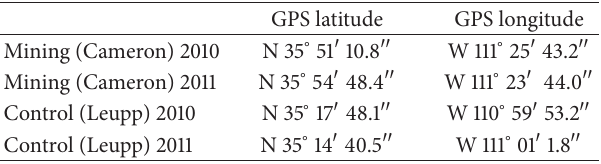
Table 1: GPS coordinates for soil collection sites. This is a summary of the soil collection sites and the corresponding GPS